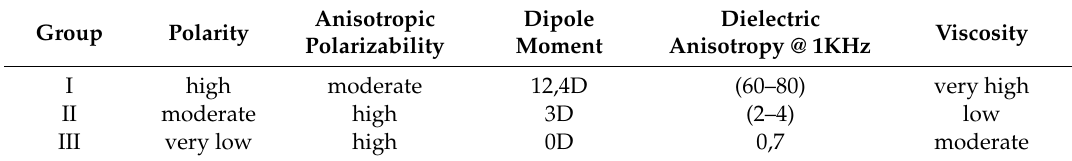
Table 2. Mesomorphic properties of the three components of the mixture under study.